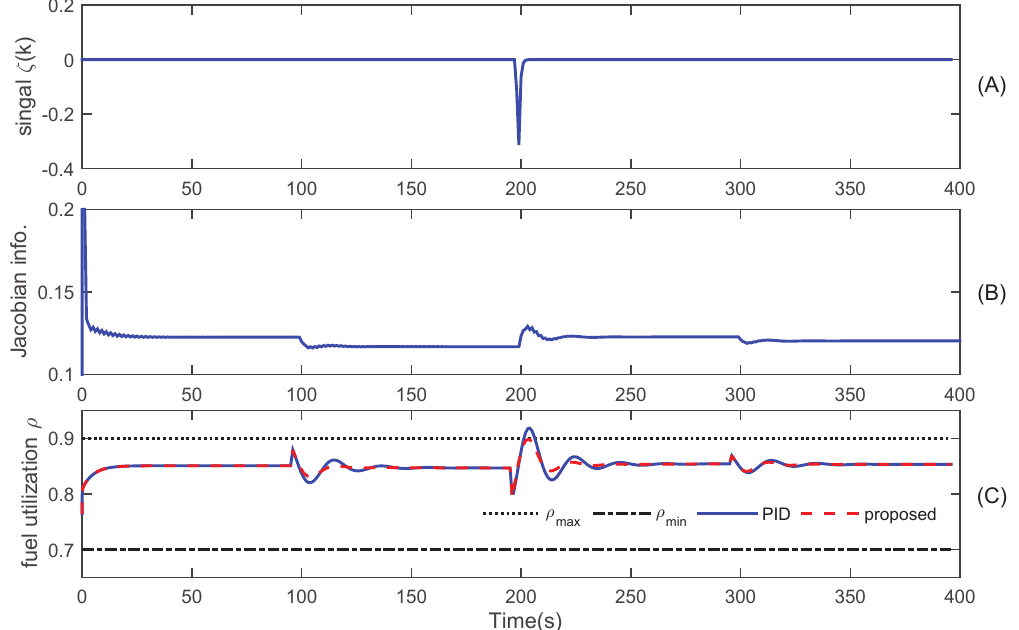
Figure 8. Anti-windup compensation signal ( A ), Jacobian information ( B ) and fuel utilization for the proposed control method compared with conventional PID control ( C